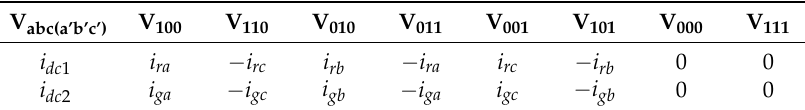
Table 3. Relationships among DC and AC Currents in rotor-side converter (RSC) and grid-side converter